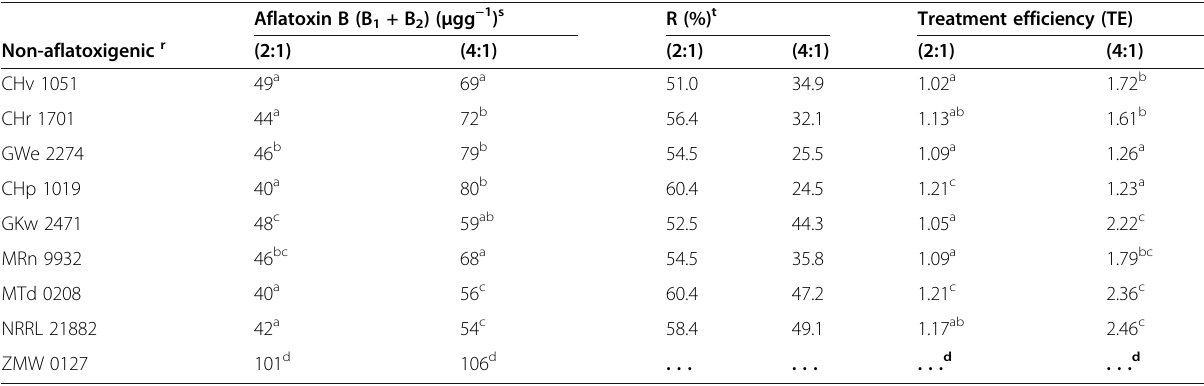
Table 3 Influence of non-aflatoxigenic and aflatoxigenic ratios of A. flavus. on reduction of aflatoxins produced by aflatoxigenic isolates of A. flavus (ZMW